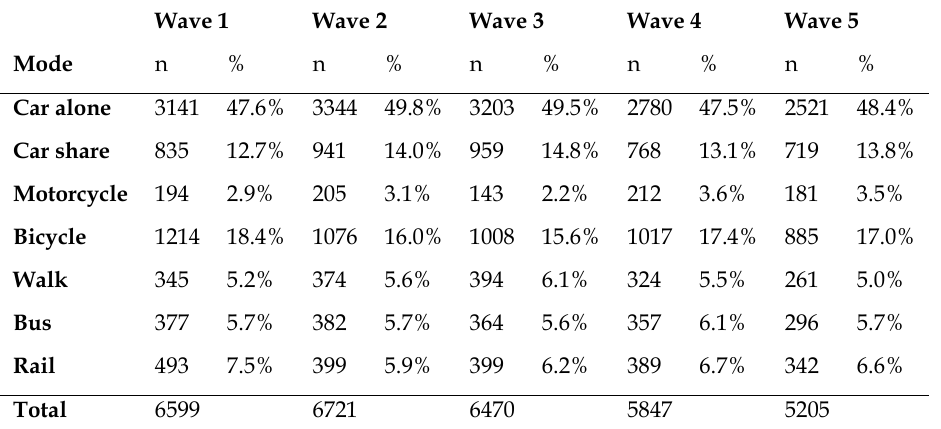
Table 5. Number of person-days using different modes of transport (as main mode) Wave 1 Wave 2 Wave 3 Wave 4 Wave